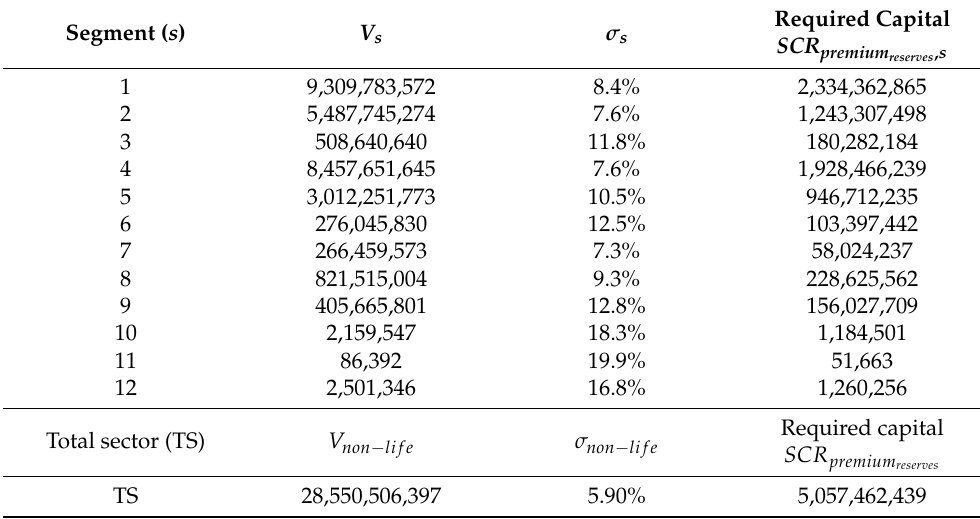
Table 4. Required capital for the premium and reserve risk for the Spanish insurance sector (segment and total